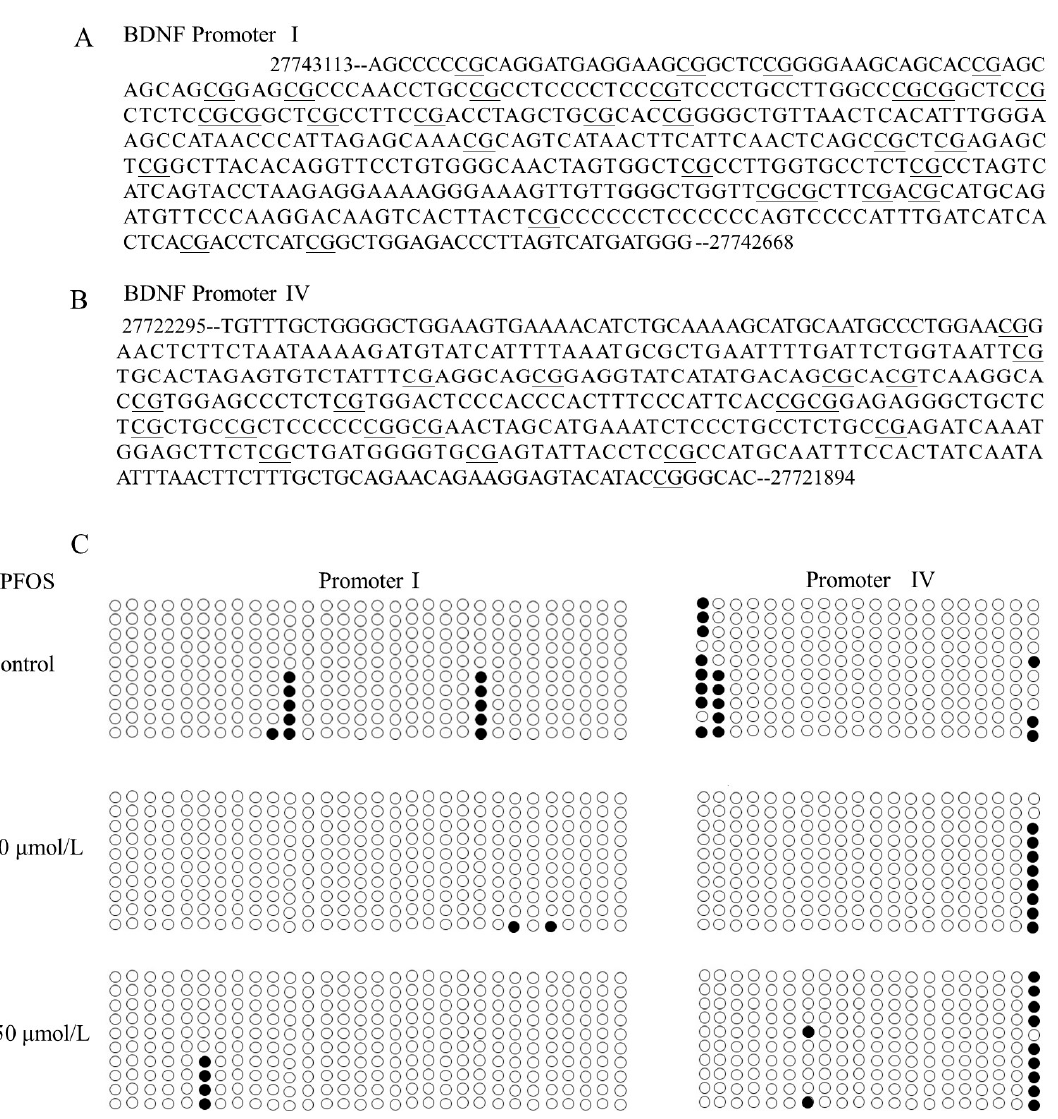
Figure 4. Bisulfite-sequencing methylation analysis of individual CpG dinucleotides of the BDNF promoter I ( A ) and IV ( B ) from the SK-N-SH Cells. ( A ) Locations of these 30 CpG sites within promoter I are listed and the methylation status was assessed by bisulfite sequencing. ( B ) Locations of these 20 CpG sites within promoter IV are listed and the methylation status was assessed by bisulfite sequencing. ( C ) Methylation of promoter. White and black circles denote unmethylated and methylated CpG sites, respectively. Each row indicates a specific plasmid clone. Ten clones came from the same group. The underline in the image ( A , B ) represent CpG dinucleotides